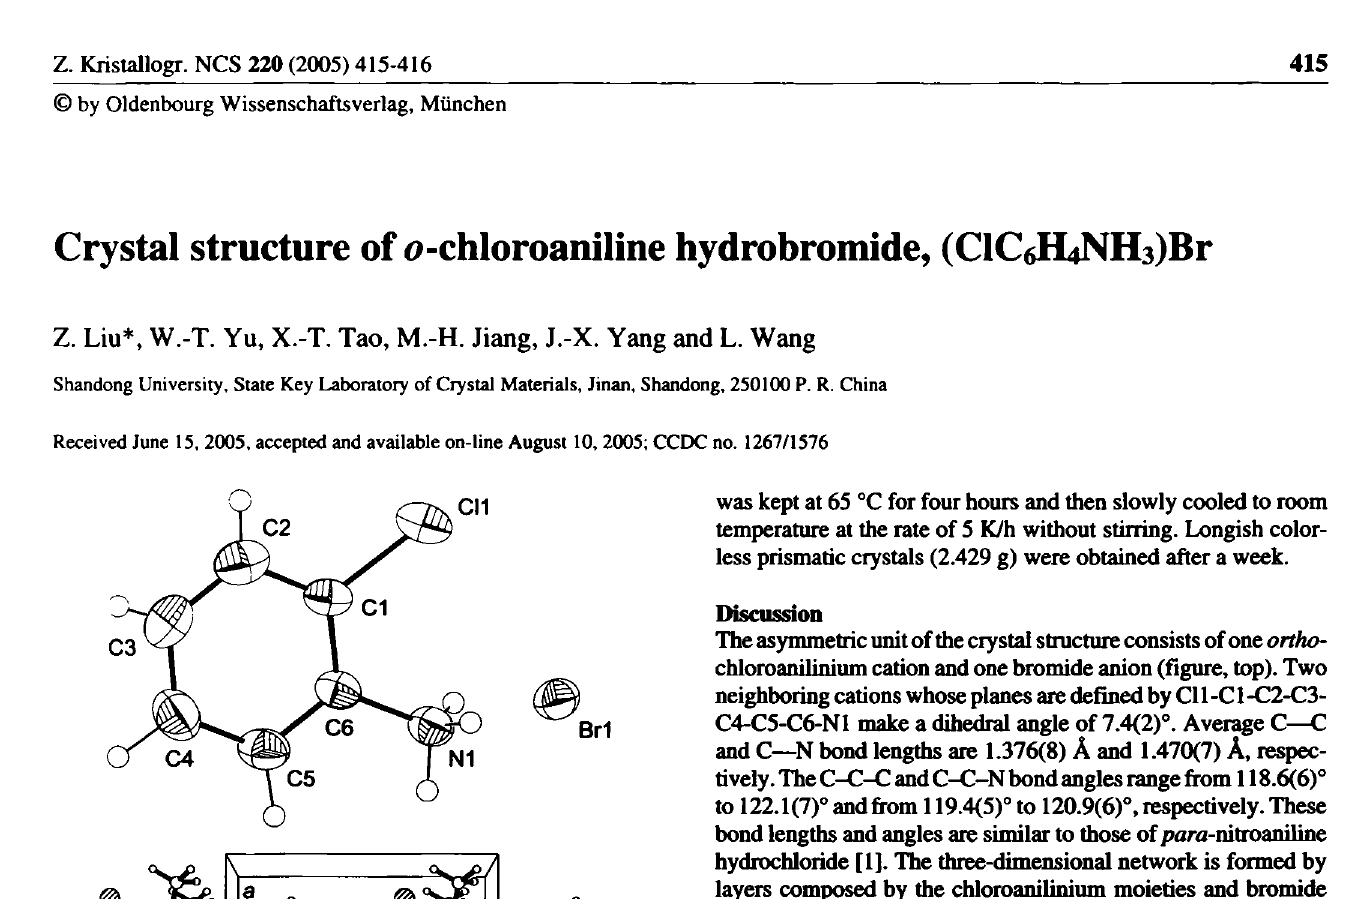
Table 1. Data collection and handling.